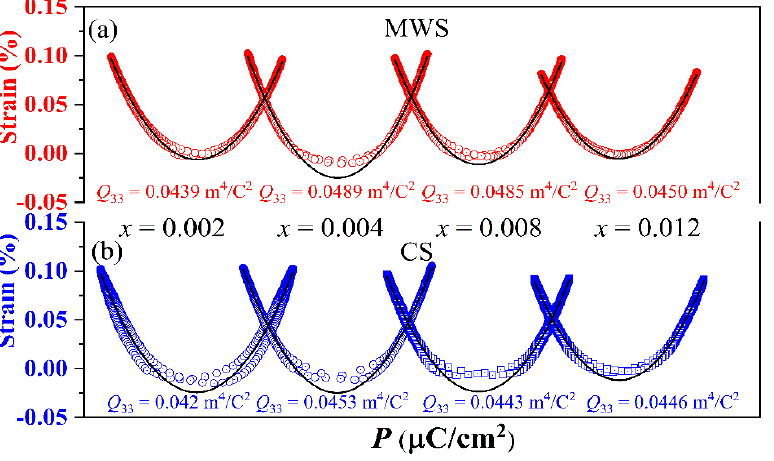
Figure 8. S - P loops of BST-BCT- x BF ceramics sintered with ( a ) MWS and ( b ) CS.